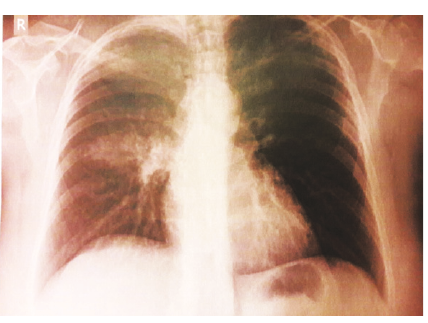
Figure 1: Patient’s chest X-ray demonstrating a right upper lobe